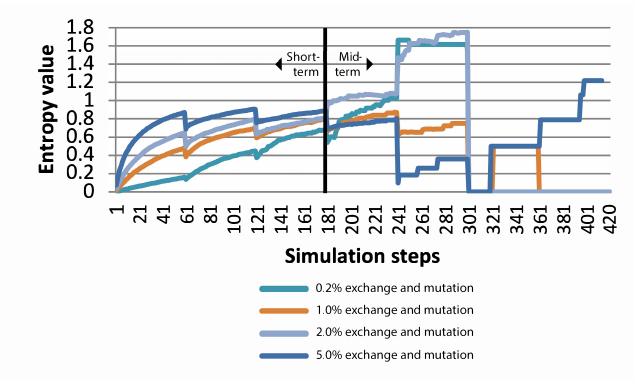
Figure 6. MPGA results applying severe SAWs of